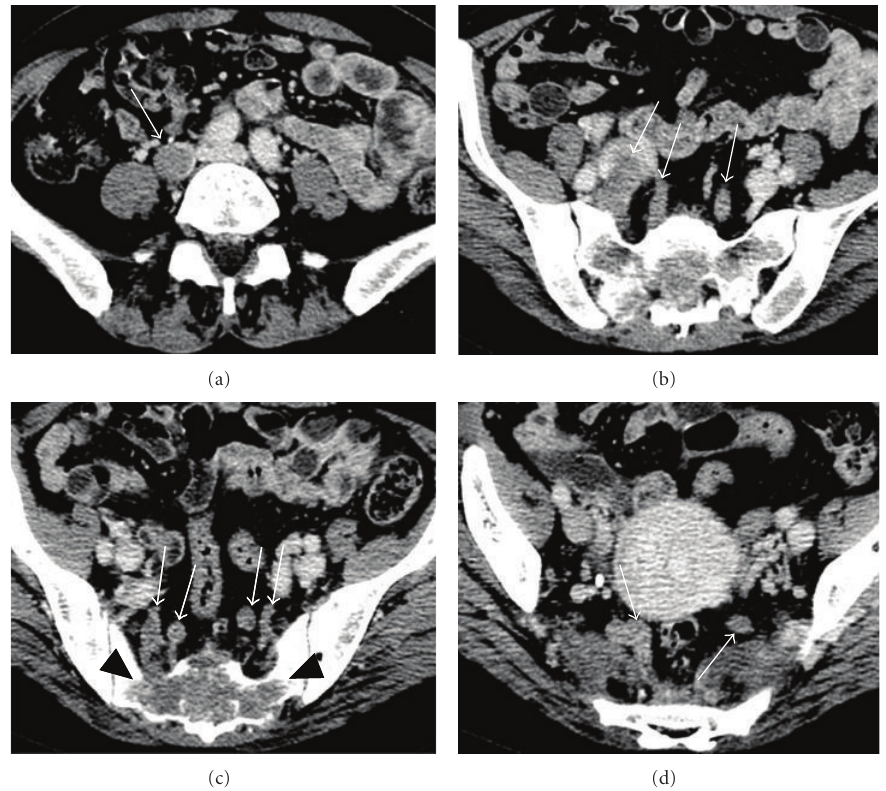
Figure 2: Contrast-enhanced CT demonstrated intraluminal filling defects in the right common iliac vein, both internal iliac veins, and their branches ((a)–(d)) (white arrows). A lytic lesion in the sacrum was also noted (c) (black arrowheads) and continuity between the sacral lesion and the filling defect in the branch of the right internal iliac vein was